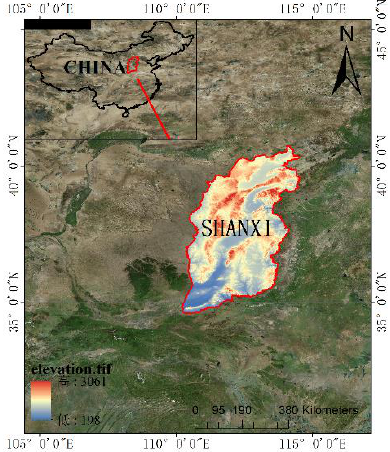
Figure 1 . Location and the elevation of Shanxi